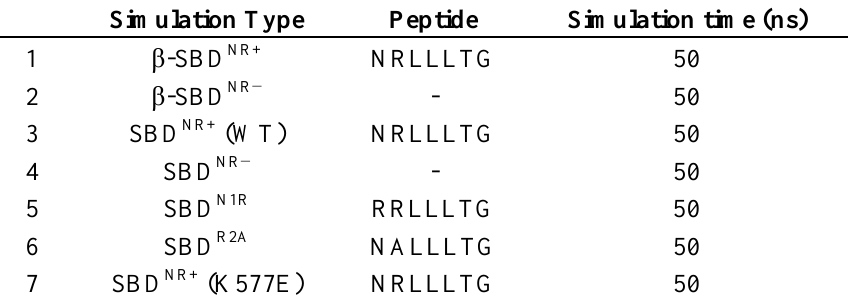
Table 1. List of MD